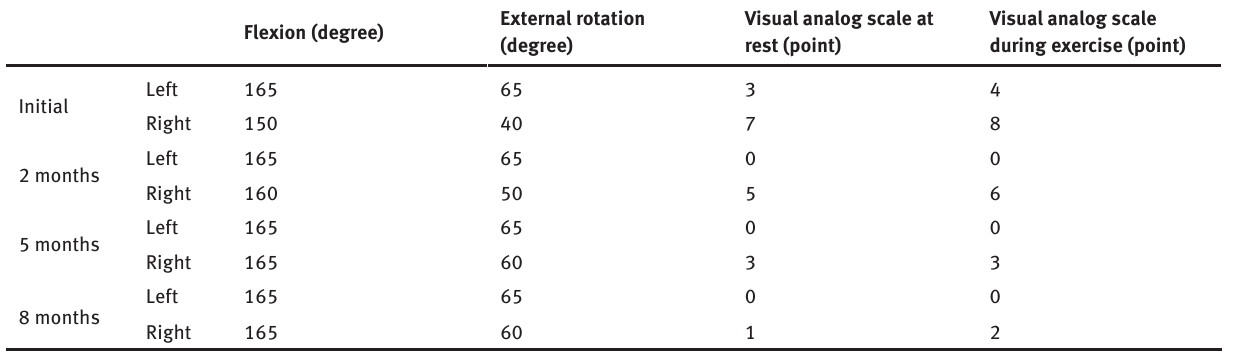
Table 1. Results of range of motion and visual analog scales in Patient 1